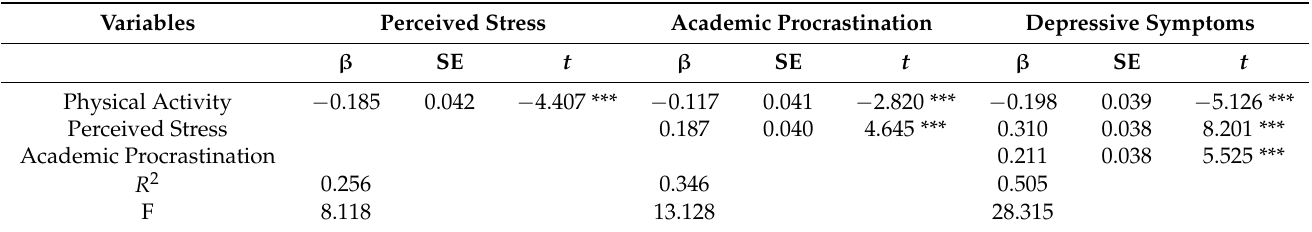
Table 3. Regression analysis of the mediating model between perceived stress and academic burnout and physical activity and depressive symptoms.